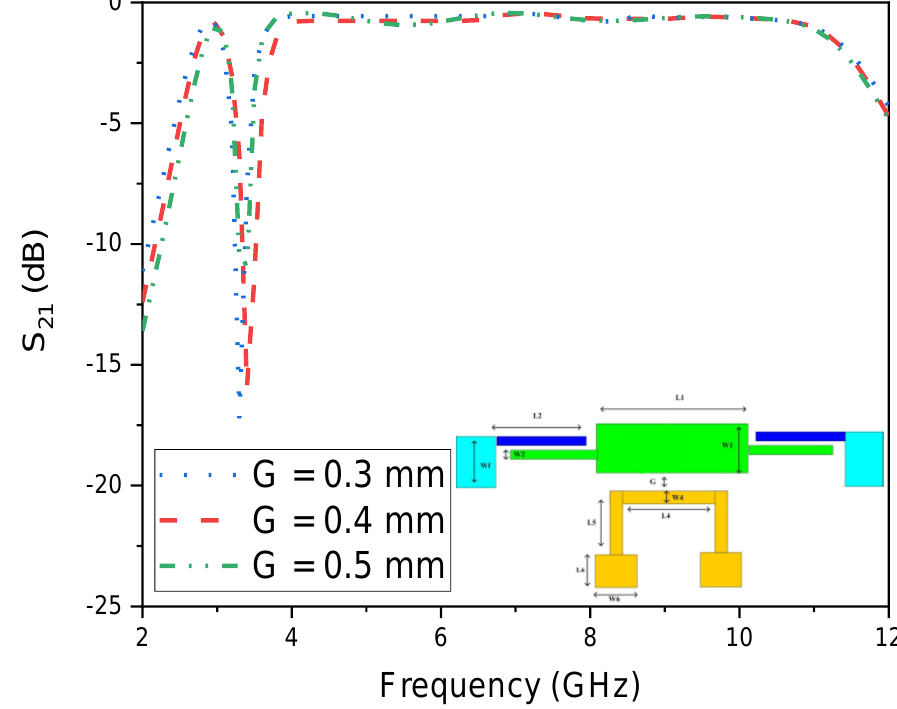
Figure 9. The magnitude of | S 21 | under different coupling scheme w.r.t parameter L 2 . Now, the attention is shifted to how notched bands are formed in the ultrawide pass- band filter. As discussed above, the two stopbands are formed by the embedded spur line resonator structure with the gap G = 0.3 mm. The first notch band for eliminating the fre- mission line, while the second notch band obtained for eliminating the frequency at 7.5